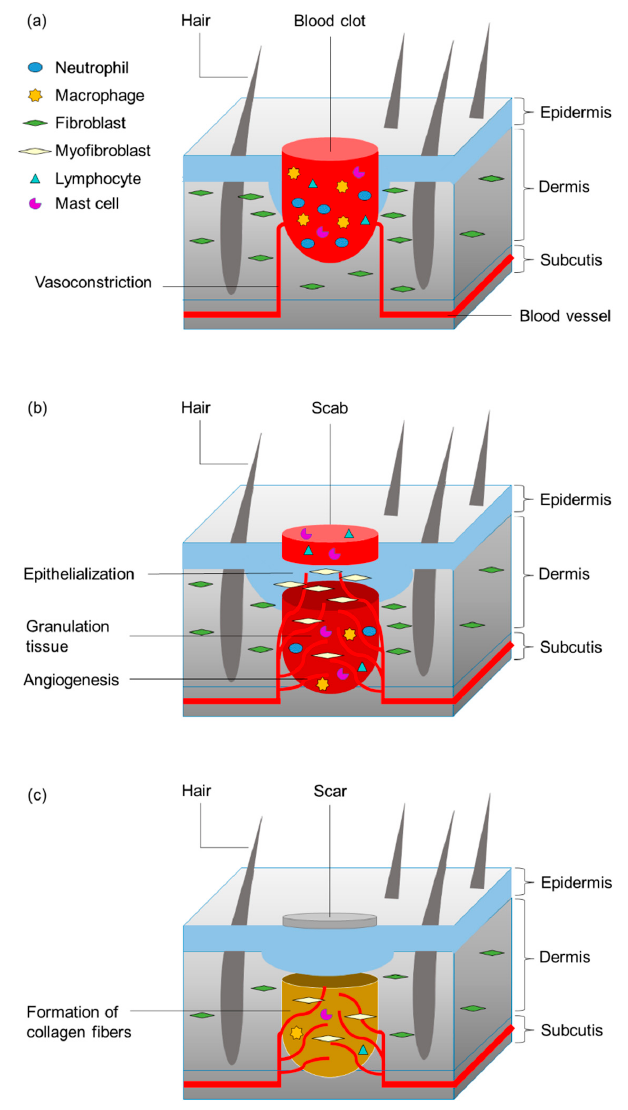
Figure 3. Phases of human wound reaction after a full-thickness skin injury. ( a ) Hemostasis and inflammation; ( b ) proliferation and maturation (new tissue formation); and ( c ) remodeling (with scarring).